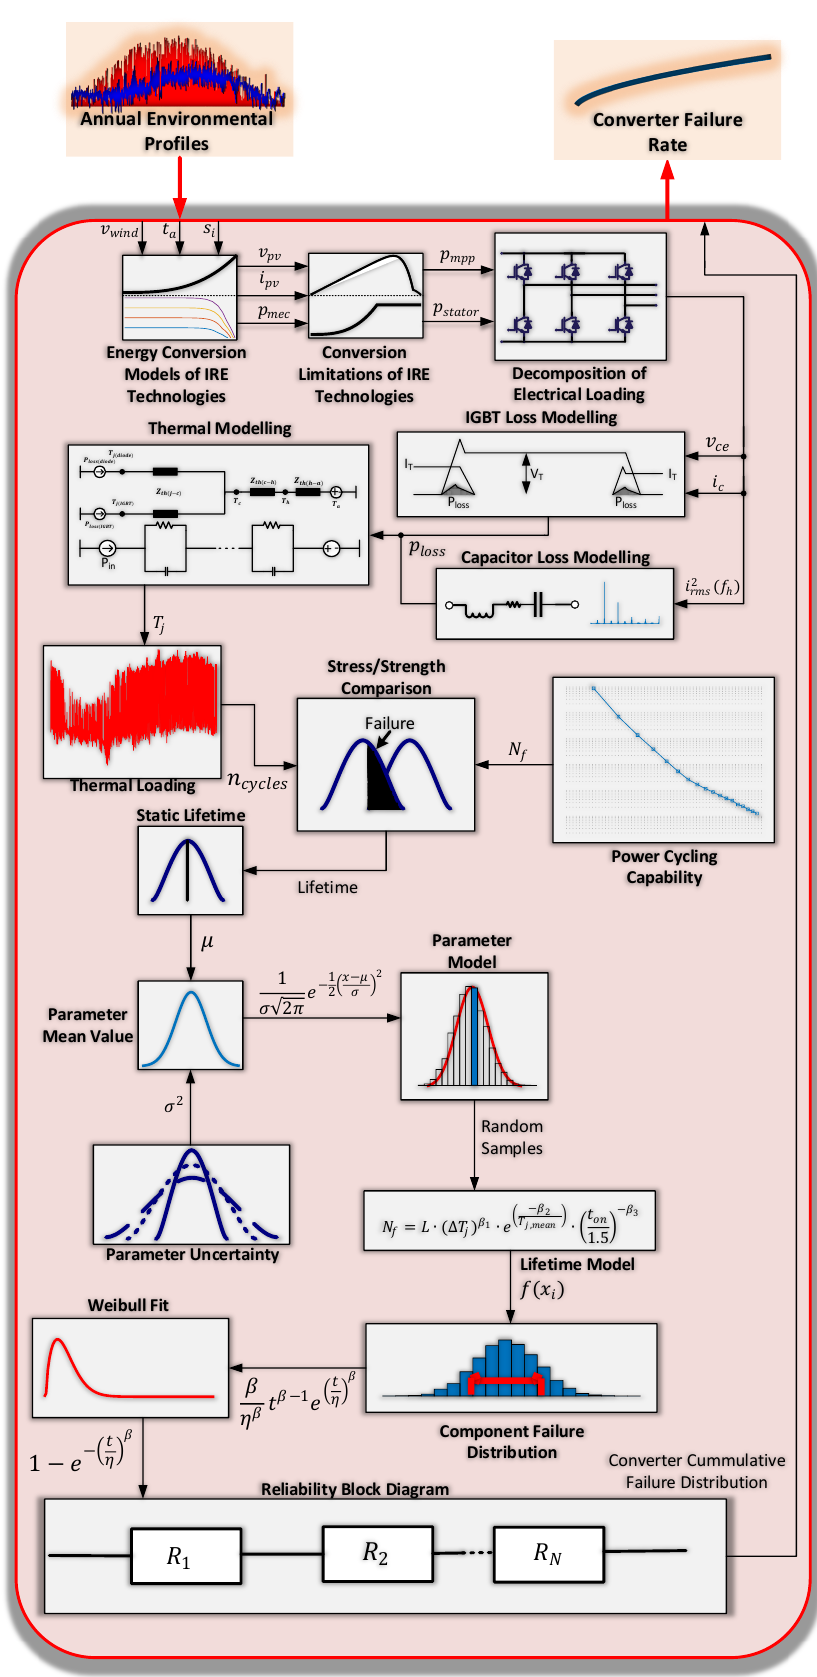
Figure 9. Workflow needed to obtain the failure rates of power